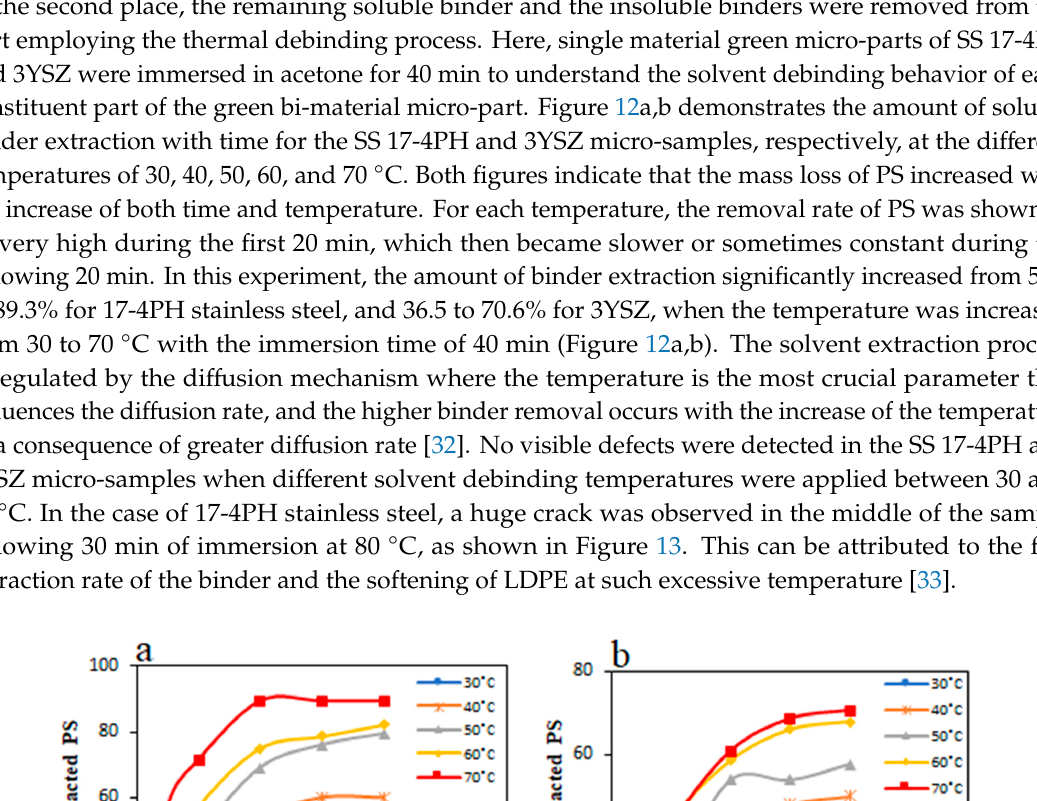
Figure 13. Cracking defect within SS 17-4PH micro-part during solvent extraction at 80 °C.